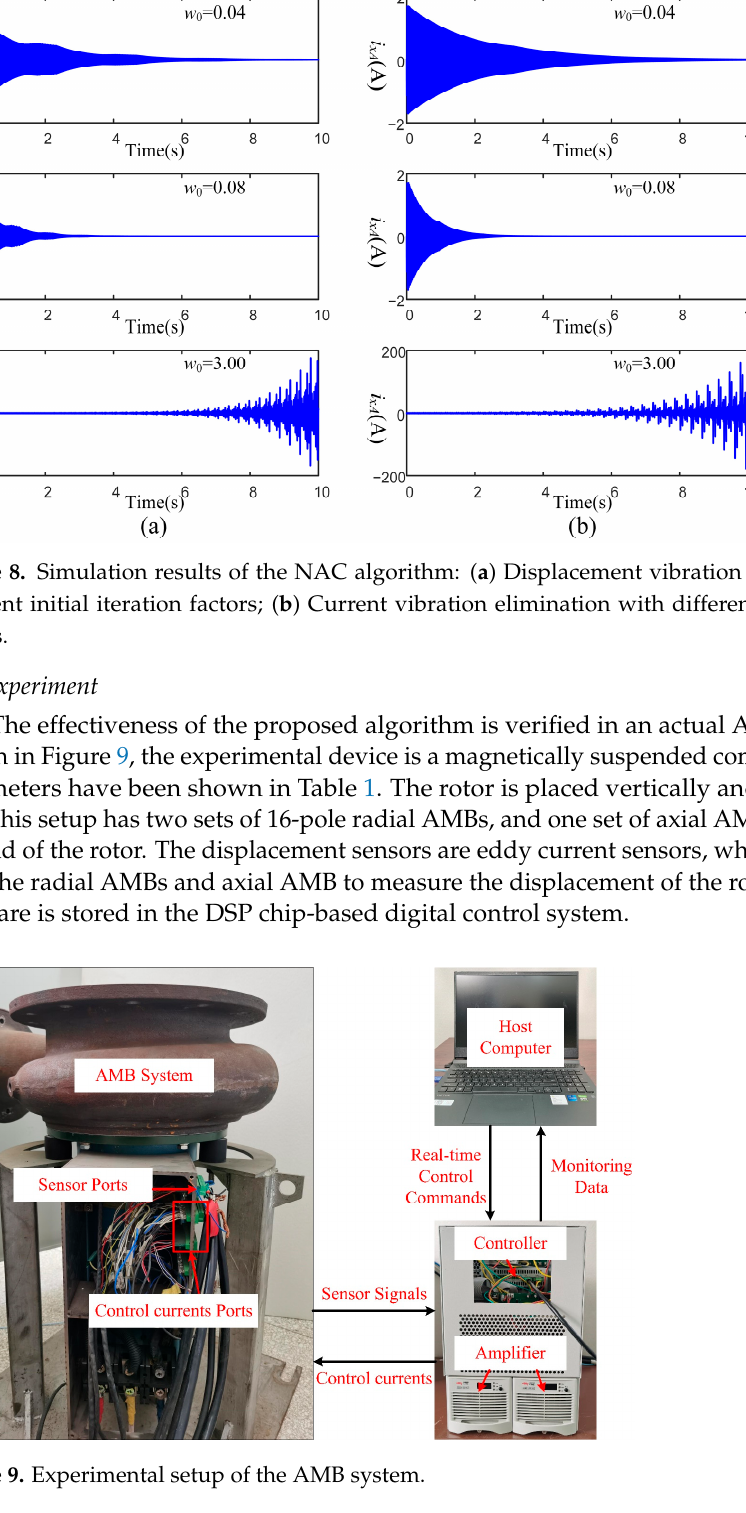
Figure 7. Noise immunity of the novel frequency estimator: ( a ) SNR = 20 dB; ( b ) SNR = 13 dB.